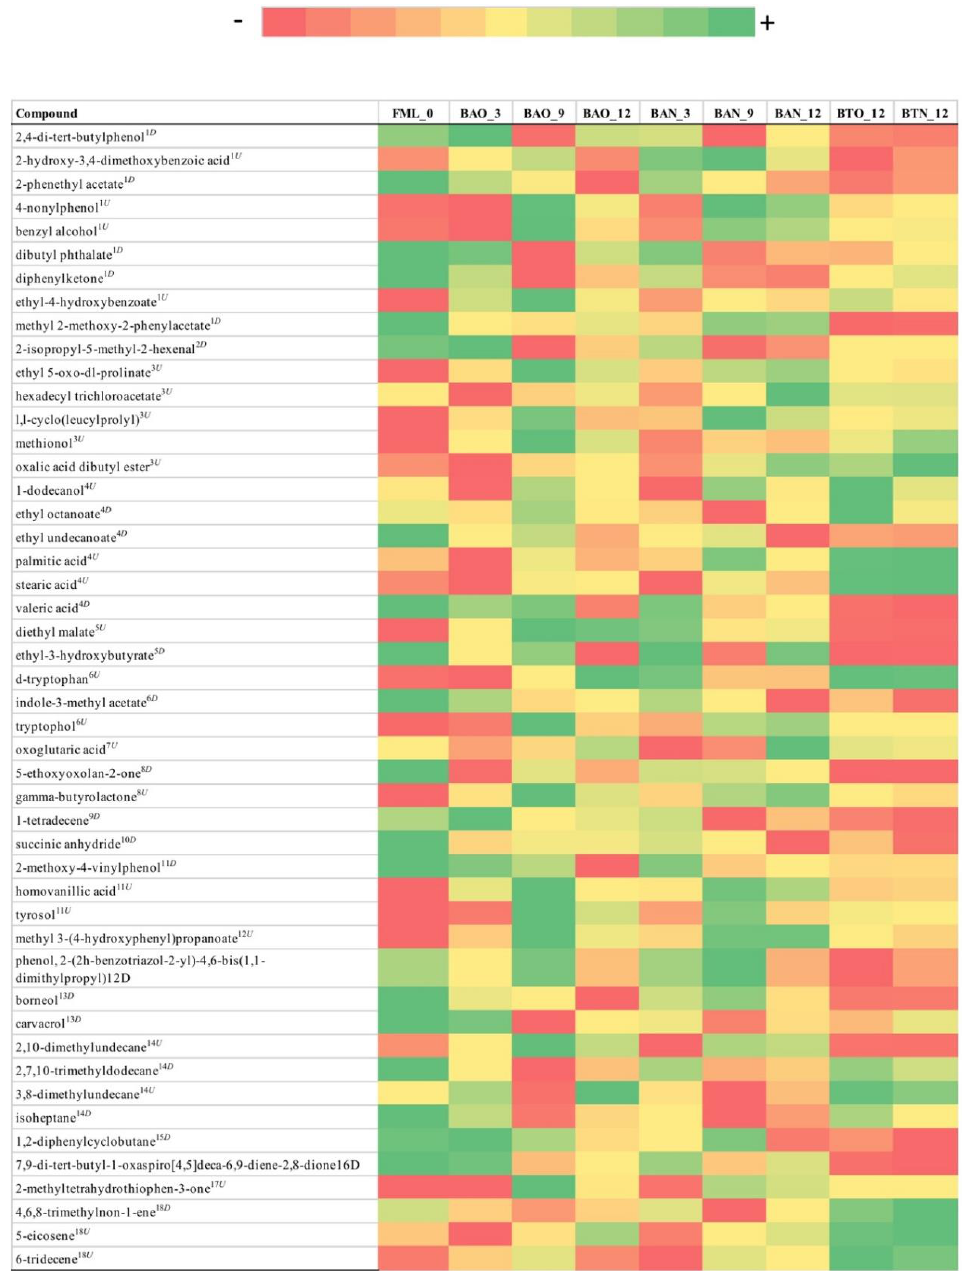
Figure 7. Color coded visualization of Table S6 included in the Supplementary Materials showing the metabolites detected by GC-MS with statistical and practical significance, for cellar ICVV. Numbers at the end of the sample acronyms represent the sampling month. The color gradient was individualized for each metabolite and the numeric values representing the area of the detected chromatographic peaks after applying variance stabilization are available in Supplementary Table S6. The metabolites can be grouped in the following chemical classes: (1) benzene and substituted derivatives, (2) carbonyl compounds, (3) carboxylic acids and derivatives, (4) fatty acyls, (5) hydroxy acids and derivatives, (6) indoles and derivatives, (7) keto acids and derivatives, (8) lactones, (9) olefins, (10) oxolanes, (11) phenols, (12) phenylpropanoic acids, (13) phenol lipids, (14) saturated hydrocarbons, (15) stilbenes, (16) tetrahydrofurans, (17) thiolanes, (18) unsaturated hydrocarbons. Metabolites that exhibited increasing tendency are indicated as superscript (U) and those with decreasing tendency as superscript (D), whereas metabolites with relatively stable concentrations but with a peak on the 6th month are denoted as